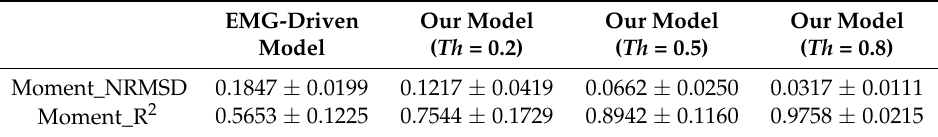
Figure 7. Joint moment estimation of EMG-driven model and our model with different Th values ( Th = 0.2, 0.5, 0.8). The black and red solid lines represent the average experimental and estimated joint moments, respectively. The black and red dash dotted lines represent the standard deviations of the experimental and estimated joint moment, respectively. Table 1. Comparison between experimental and estimated joint moment using the EMG-driven model and our model with different Th values (the data are given as mean ±